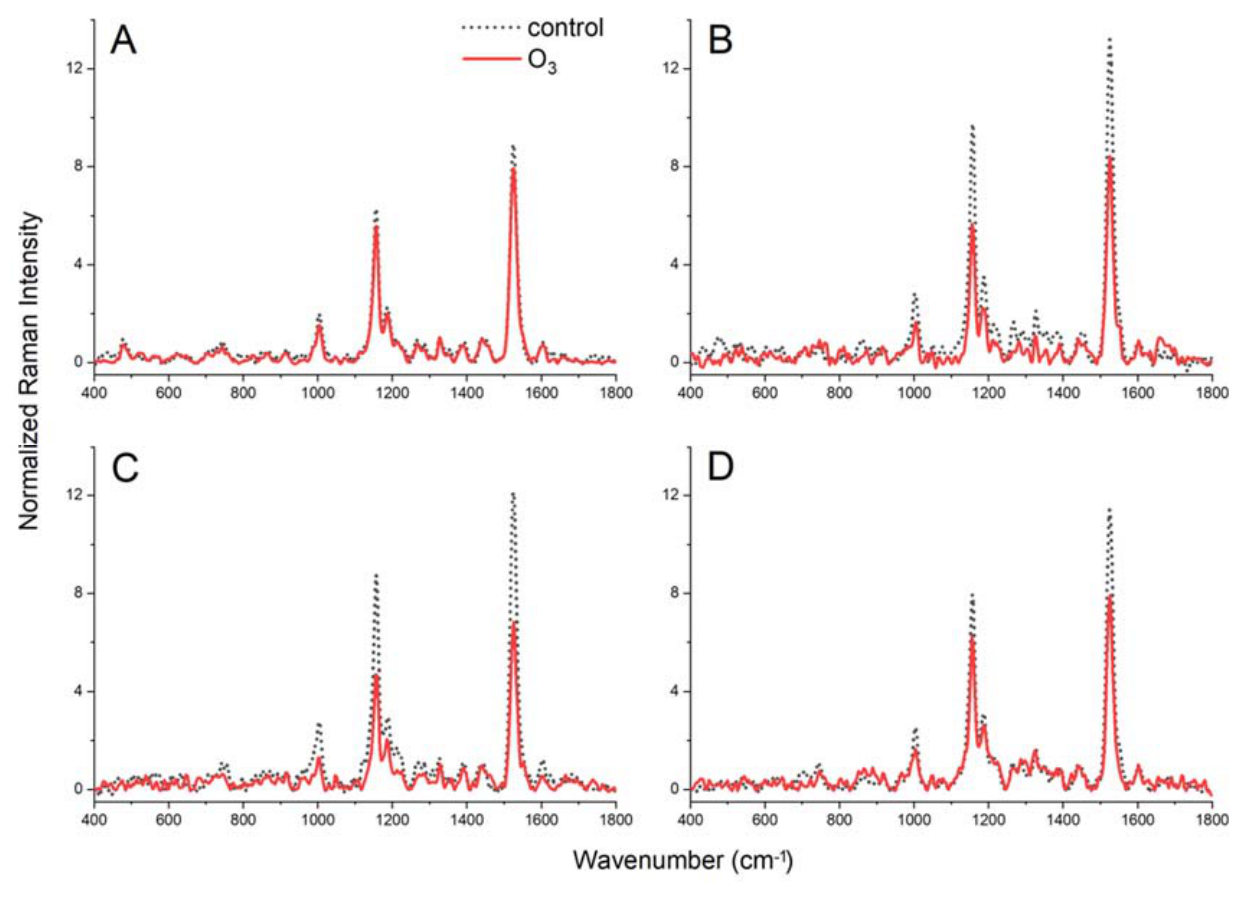
Figure 3. FT-Raman spectra, normalised according to 1441 cm − 1 , obtained for lyophilised leaves of Brassica rapa subsp. pekinensis growing in different light spectra: ( A ) yellow light (sodium lamp, YL), ( B ) white light (WL), ( C ) light with a dominant blue component (WBL) and ( D ) light with a dominant red component (RGBL). Solid line—spectra obtained after 21 days of ozone fumigation and dashed line—spectra for non-fumigated plants (control). Particular spectra represent the average values of 10 replications.